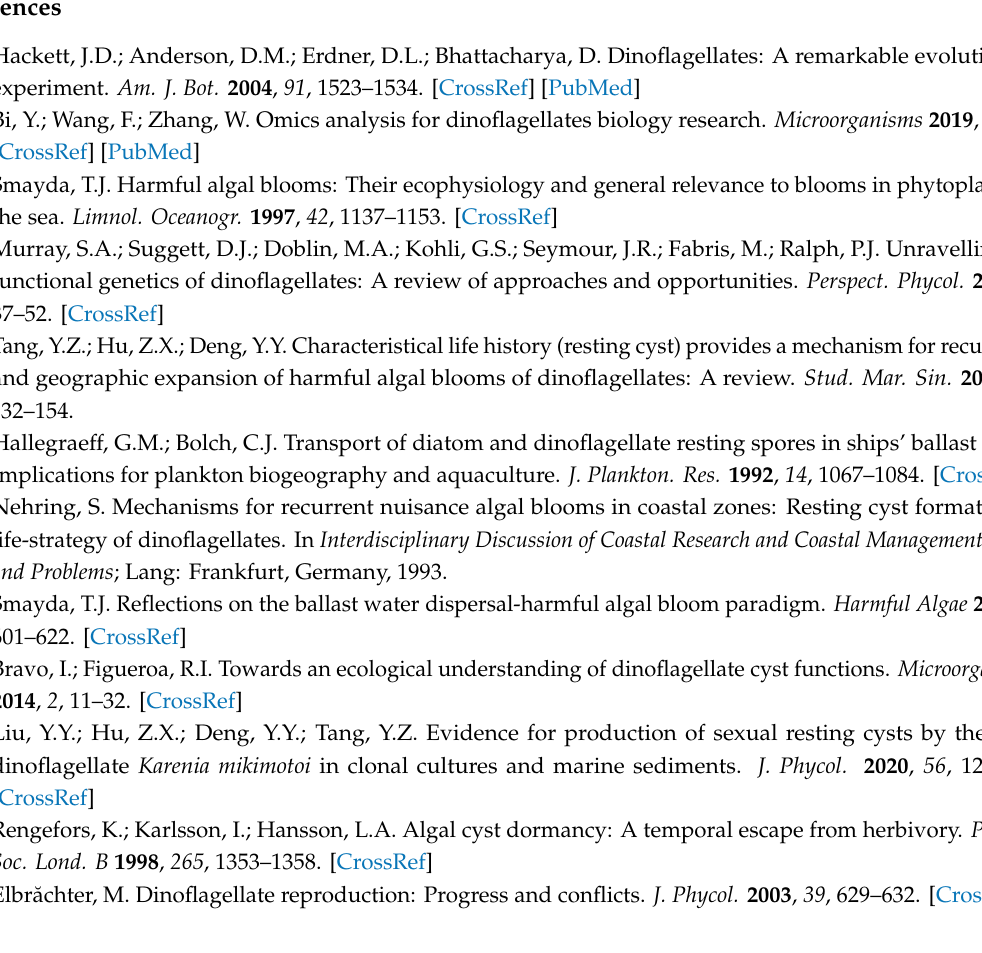
Figure S1: Morphological observations for (A) vegetative cell and (B) resting cyst of Scrippsiella trochoidea under light microscope, Figure S2: Growth curve of vegetative cells of Scrippsiella trochoidea